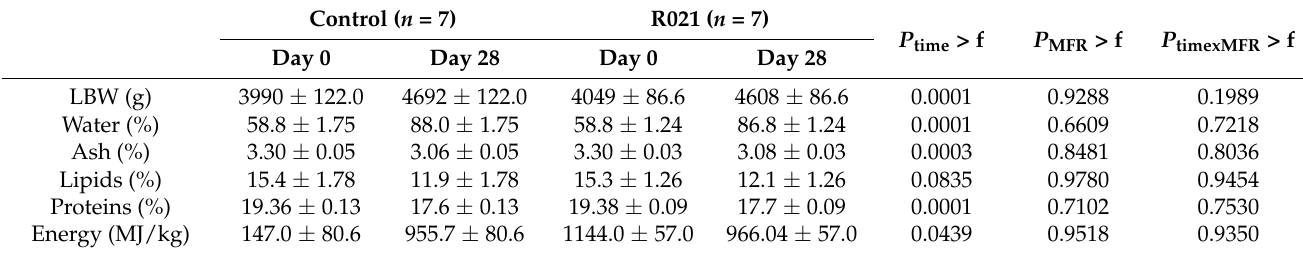
Table 1. Effect of time (Day 0 and Day 28 of pregnancy) and maternal food restriction (MFR) on live body weight (LBW) and estimated body composition of ad libitum (control group) and fed restricted females (105 g/day) during the first two-third of gestation and re-fed ad libitum until term (R021 group). Day 0, day of artificial insemination (AI); length of gestation, 31 days.